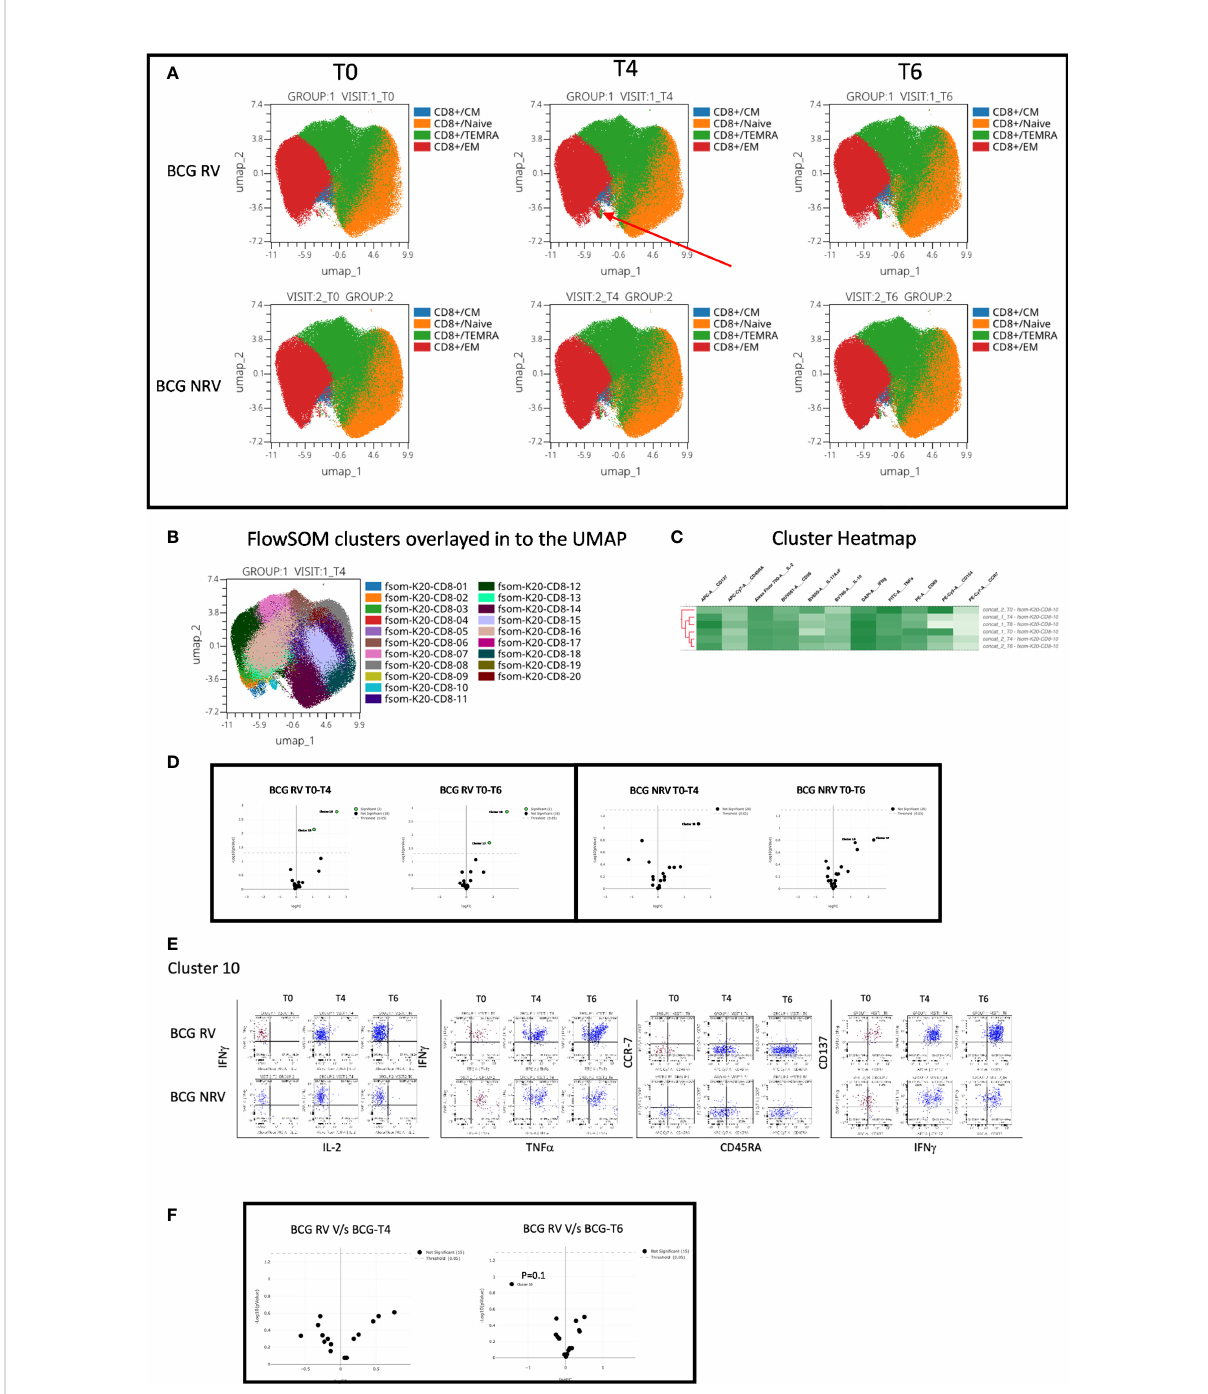
FIGURE 6 Overview of COVISHILED ™ vaccine induced spike speci fi c CD8+ T cell responses in BCG-RV and BCG-NRV subjects measured at baseline (T0), post-prime (T4) and post-boost (T6). (A) UMAP of COVISHIELD ™ vaccinated BCG-RV and BCG-NRV subjects. (B) Unbiased FlowSOM clusters overlaid in the UMAP projection axis. (C) Heatmap of cluster 10 in COVISHIELD ™ vaccinated BCG-RV and BCG-NRV subjects. (D) Volcano plot of fold change in all FlowSOM clusters in COVISHIELD ™ vaccinated BCG-RV and BCG-NRV subjects. (E) Bivariate dot plot of Cluster 10 in COVISHIELD ™ vaccinated BCG-RV and BCG-NRV subjects. (F) Volcano plot of fold change of all clusters between BCG-RV and BCG-NRV subjects T4 and